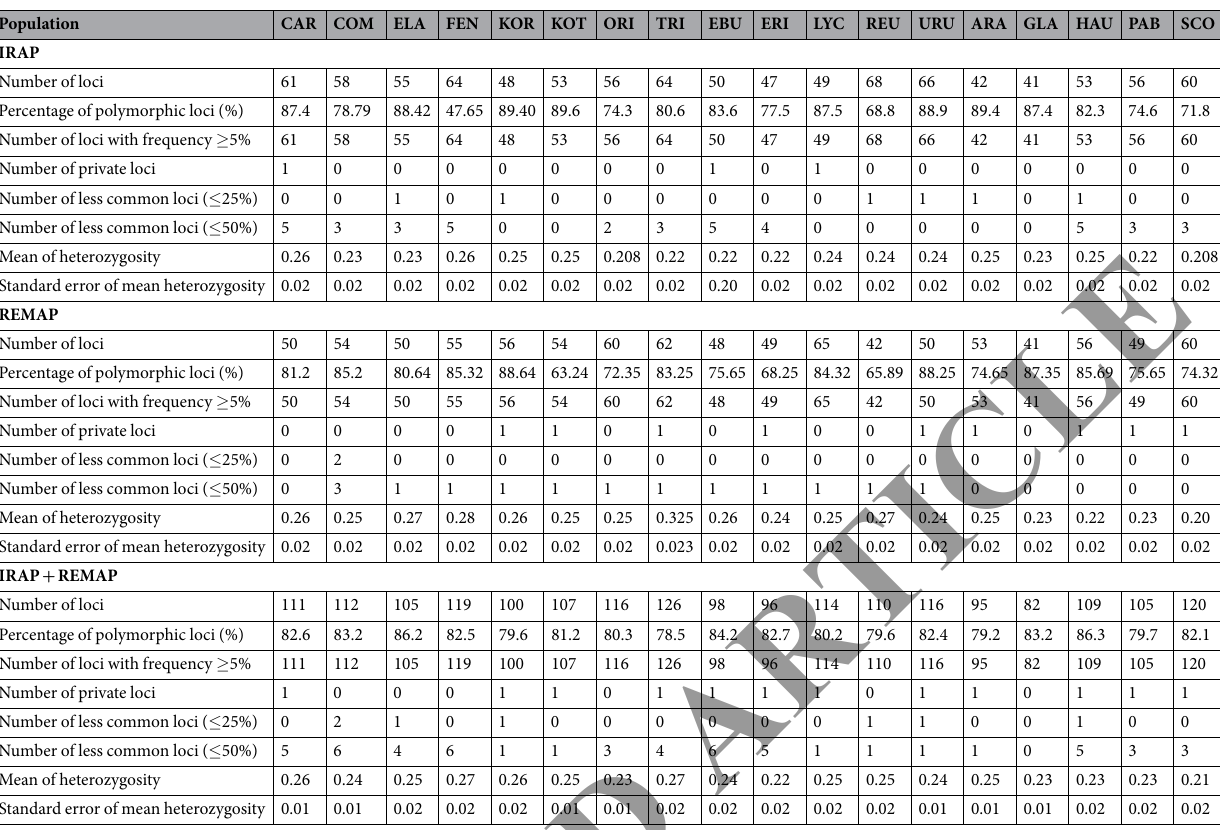
Table 3. Characteristics of amplified IRAP, REMAP and IRAP + REMAP loci in studied wild almond species